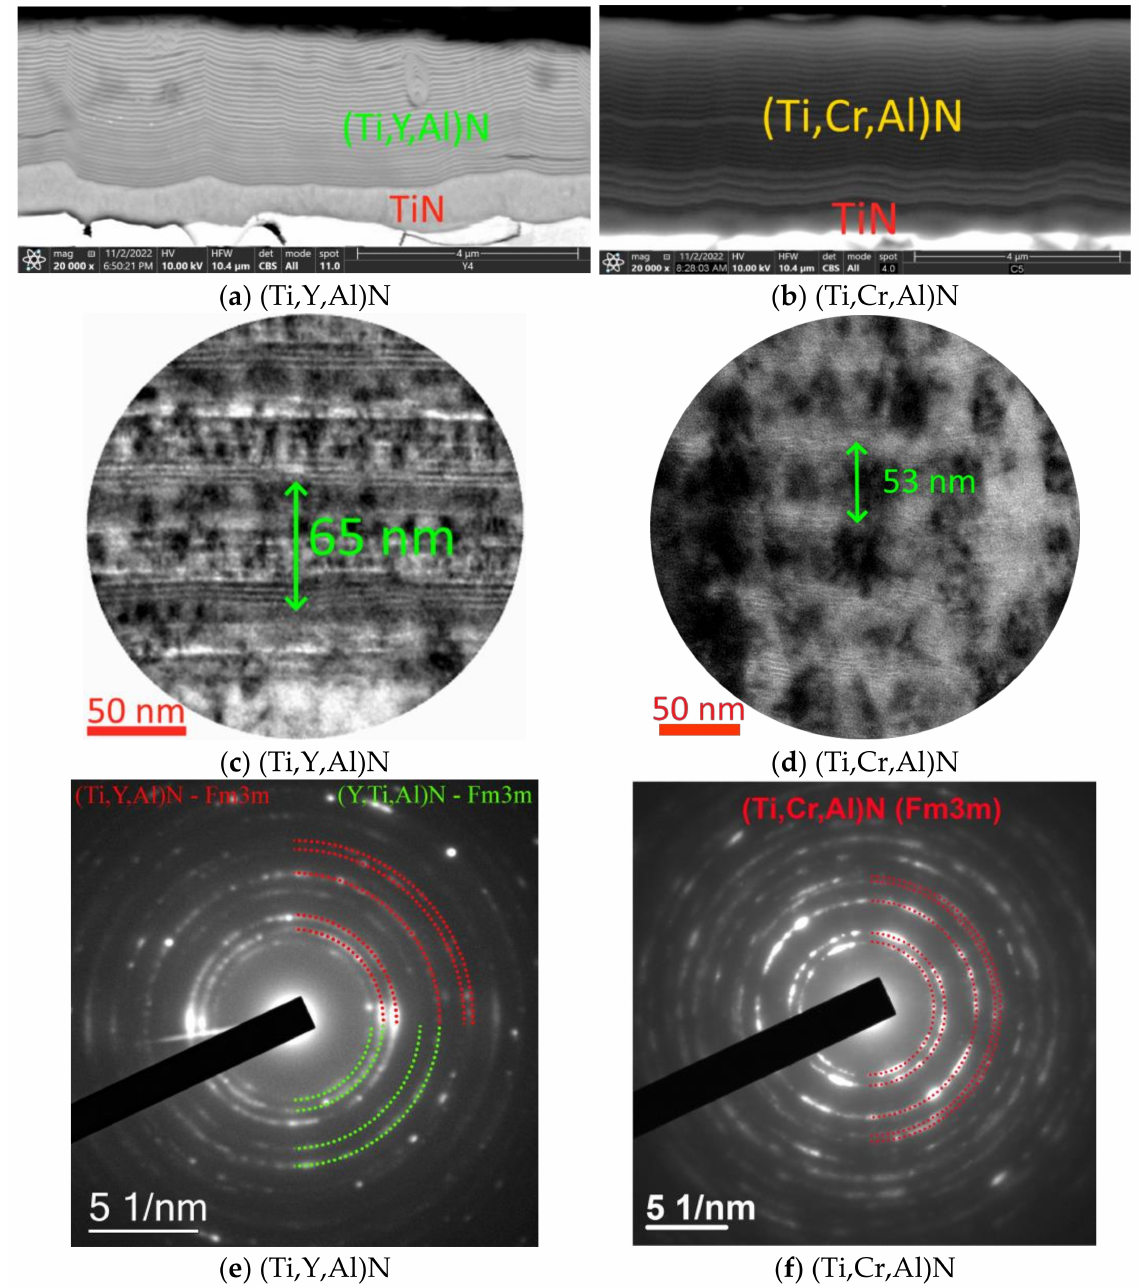
Figure 2. ( a , b ) View of transverse sections of the studied coatings (SEM), comparison of ( c , d ) the nanolayer structures (TEM) and ( e , f ) phase compositions, defined by the selected area electron diffraction pattern (SAED)